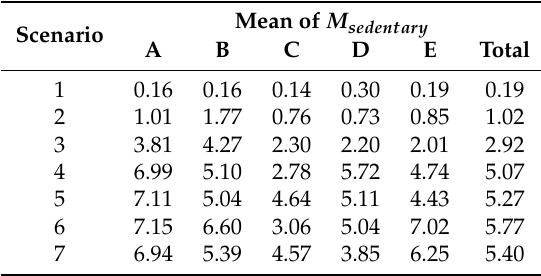
Table 1. Numerical results are shown for each target. The results for the M sedentary indicator are summarized (no unit).